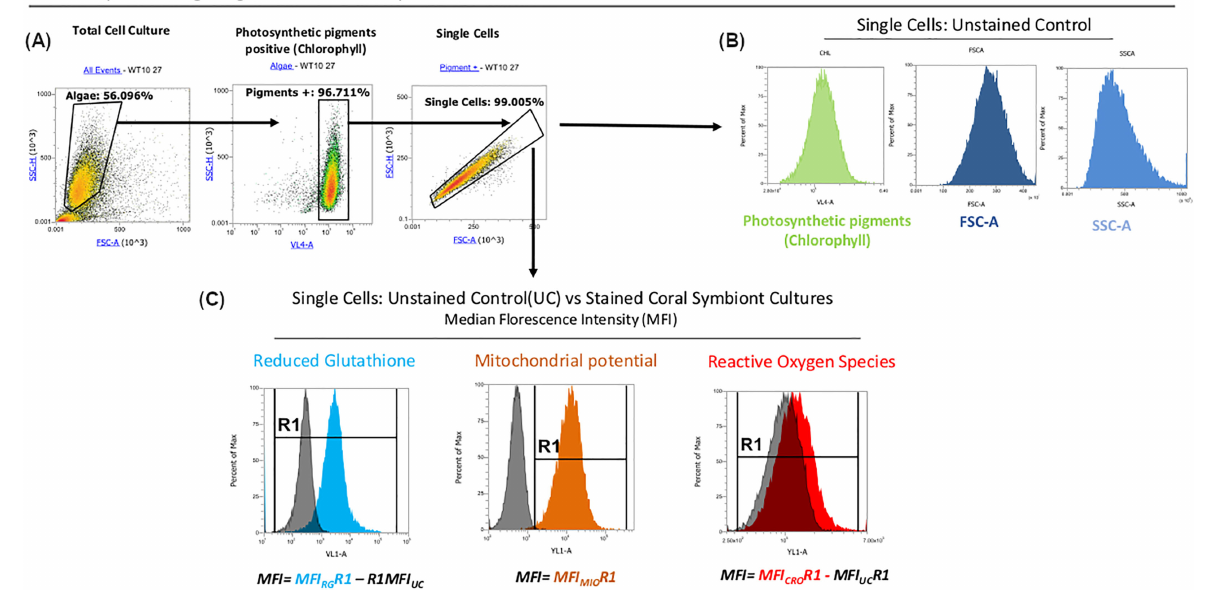
FIGURE 1 Flow cytometry work fl ow. (A) Microalgal cells were gated based on their characteristic FSC and SSC patterns. Only cells that were positive for photosynthetic pigments signal (likely chlorophyll) were selected for downstream analysis. (B) MFI values of Chlorophyll, FSC and SSC were measured in unstained controls (UCs). (C) Raw MFI values for rGHS and ROS were obtained in samples stained with Vita-Bright-48 and CellROX Orange reagents respectively and normalized by subtracting the auto fl uorescence signal from unstained controls in response to the excitation from the respective lasers. MFI values for MitoTracker Orange CMTMRos-stained cells used to measure mitochondrial potential ( DY m) were well separated from the auto fl uorescence signals of unstained controls and could therefore be analyzed without normalisation against unstained